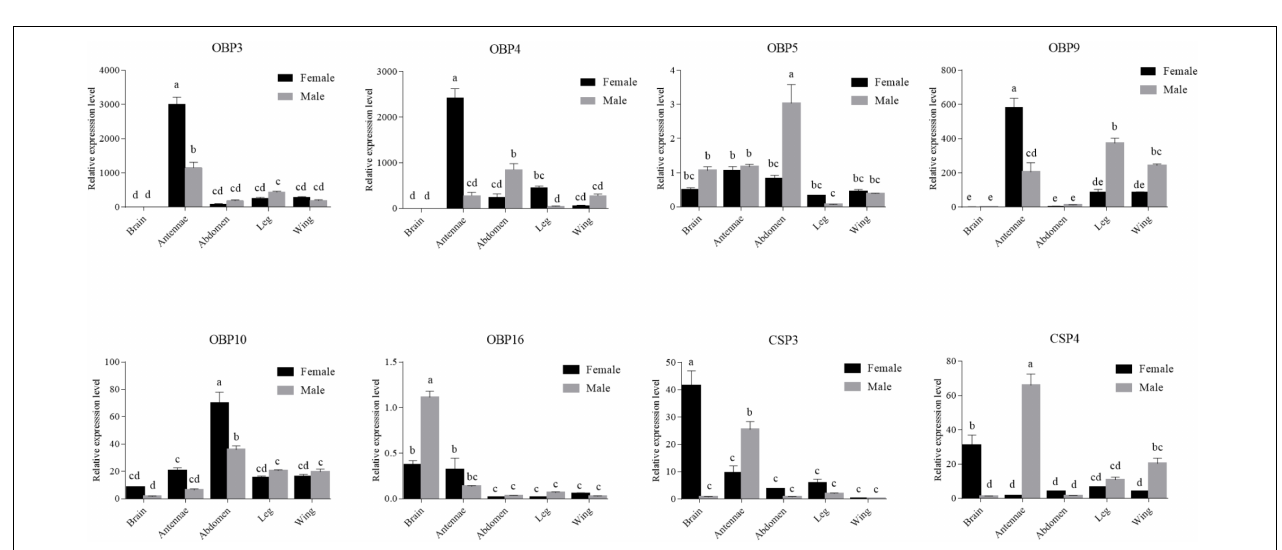
FIGURE 7 | Mythimna separata OBPs and CSPs transcript levels in different tissues of male and female adults as evaluated by RT-PCR. MB: male brains; FB: female brains; MA: male antennae; FA: female antennae; MAb: male abdomens; FAb: female abdomens; ML: male legs; FL: female legs; MW: male wings; FW: female wings.